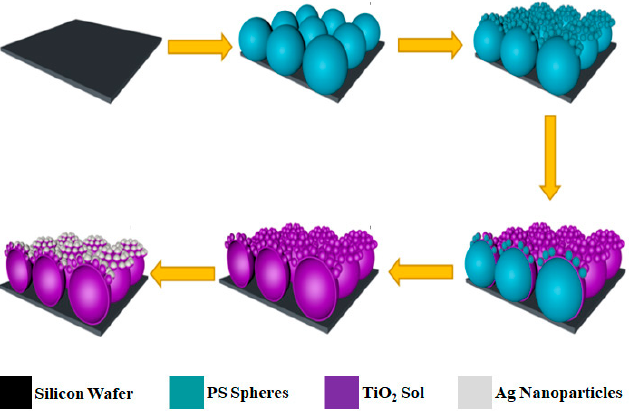
Scheme 1. Scheme of fabricating the Ag/3D-TiO 2 /Si substrate with 3D moth-like eye structure.